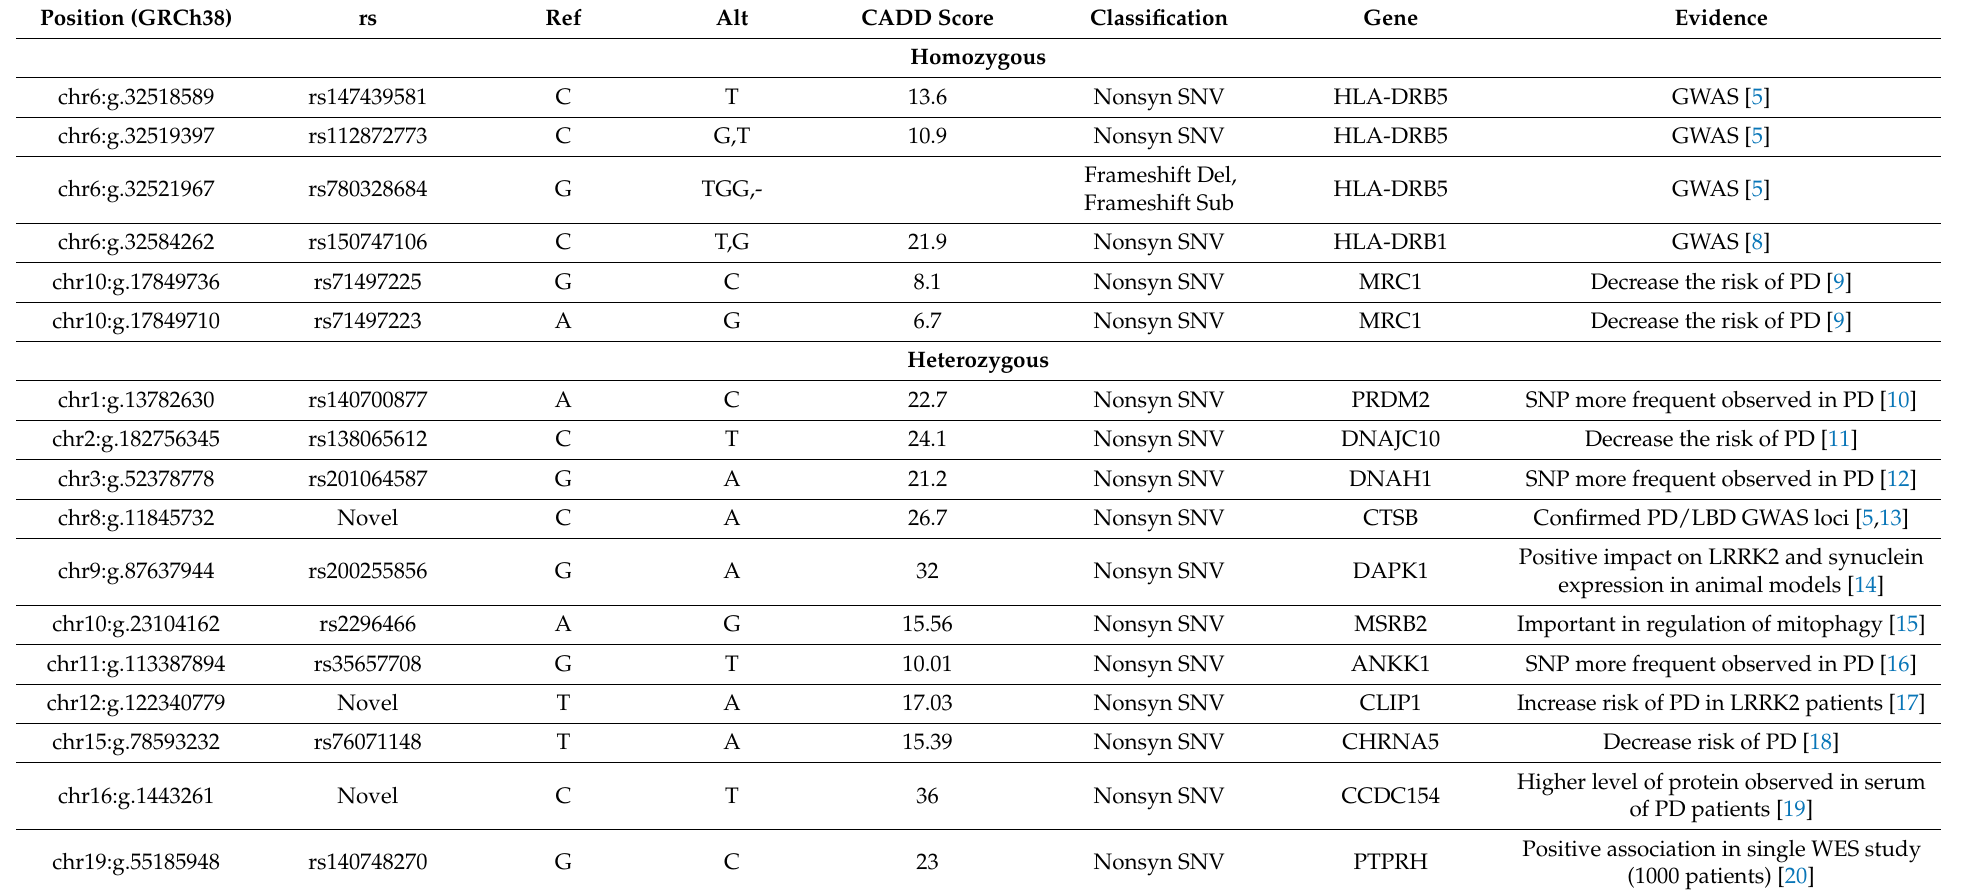
Table 1. Summary of shared variants in affected siblings previously associated with